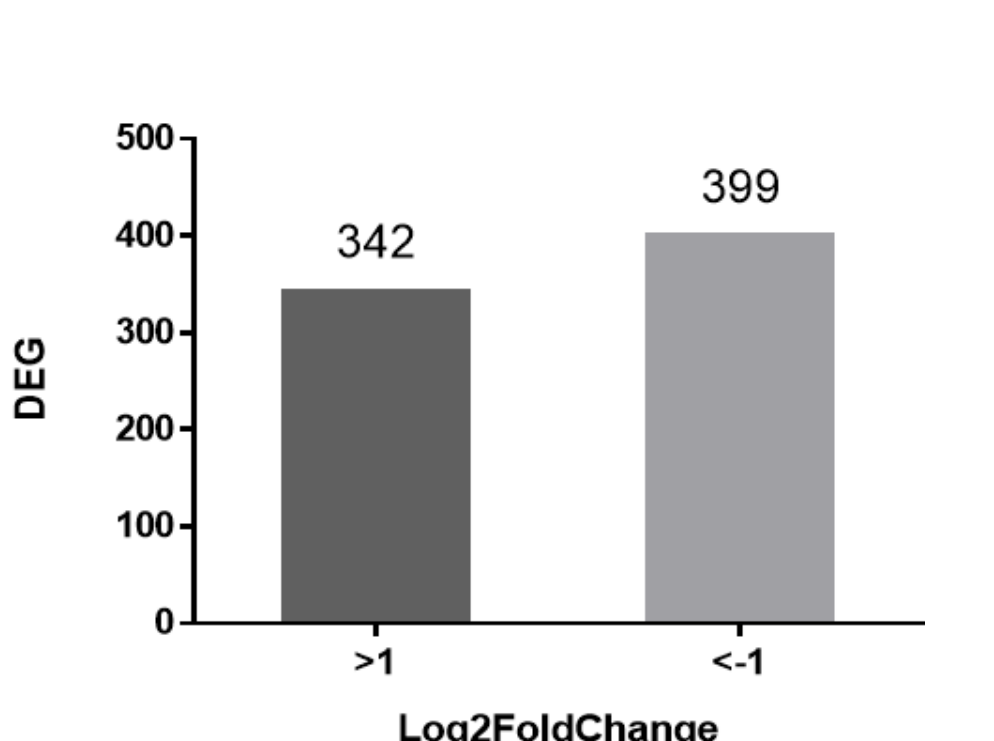
Figure 1. Analysis of DEG in mouse lumbar dorsal root ganglia L4 to L6 following repeated oxaliplatin administration. ( A ) Experimental design: C57Bl/6J mice received oxaliplatin (3 mg/kg, i.p.) or